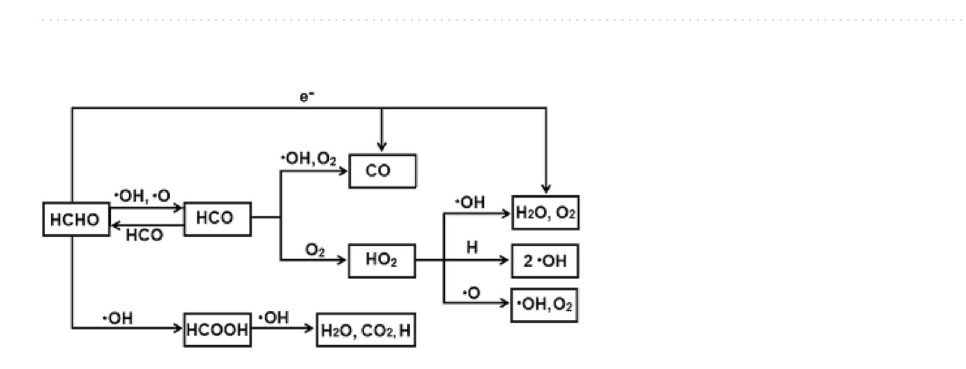
Figure 8. Suggested plasma processing degradation chemical path for HCHO removal in the contaminated indoor air